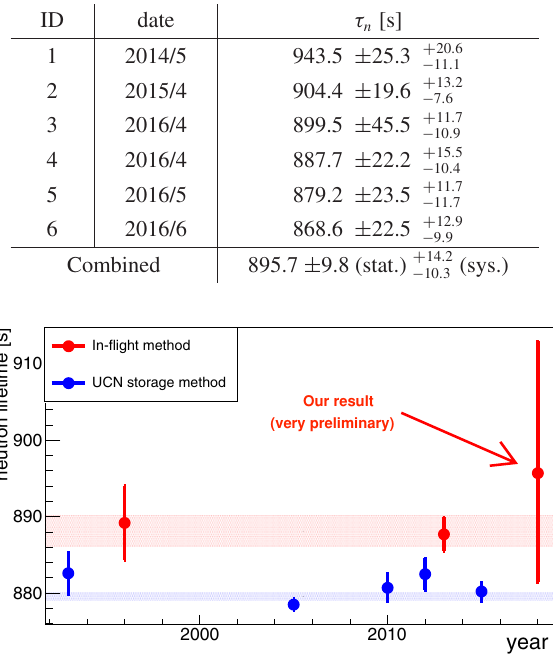
Figure 8. Our result of the neutron lifetime along with previous measurements [3]. The average of the two most recent results using the in-beam method (red) is (888.0 ± 2.0) s [9,10], while that using UCN storage (blue) is (879.6 ± 0.6) s [4–8]. The discrepancy of the two averages is 8.4 s (4.0 σ